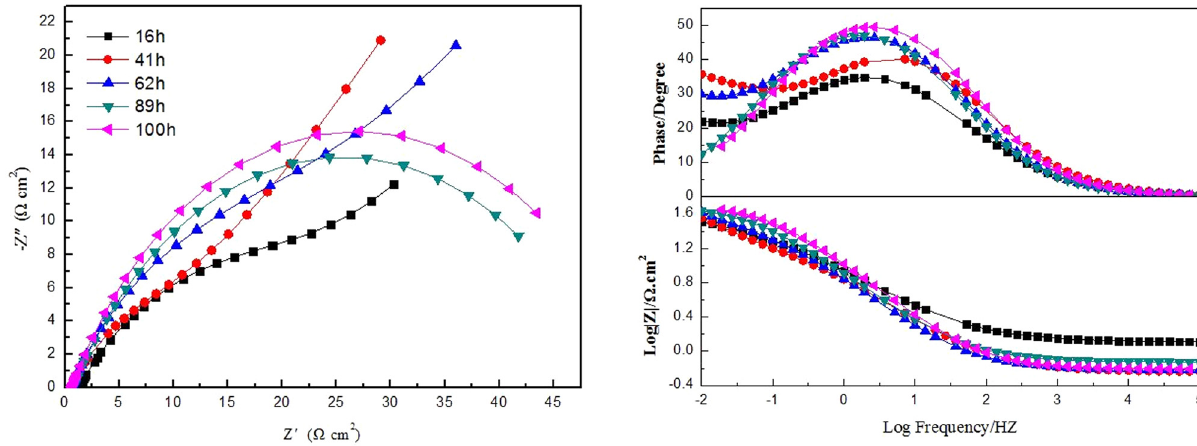
Figure 9: Impedance Nyquist plots and bode diagrams of Inconel 625 alloy in ternary chloride molten salt at 700°C.